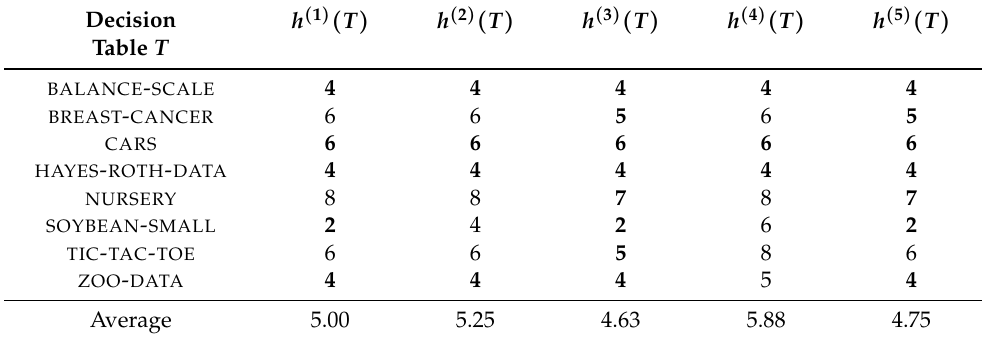
Table 2. Experimental results for decision tables from Reference [20]—depth.